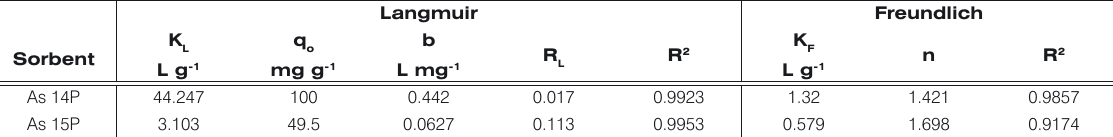
Table 5. Characteristic parameters of Langmuir and Freundlich isotherms.